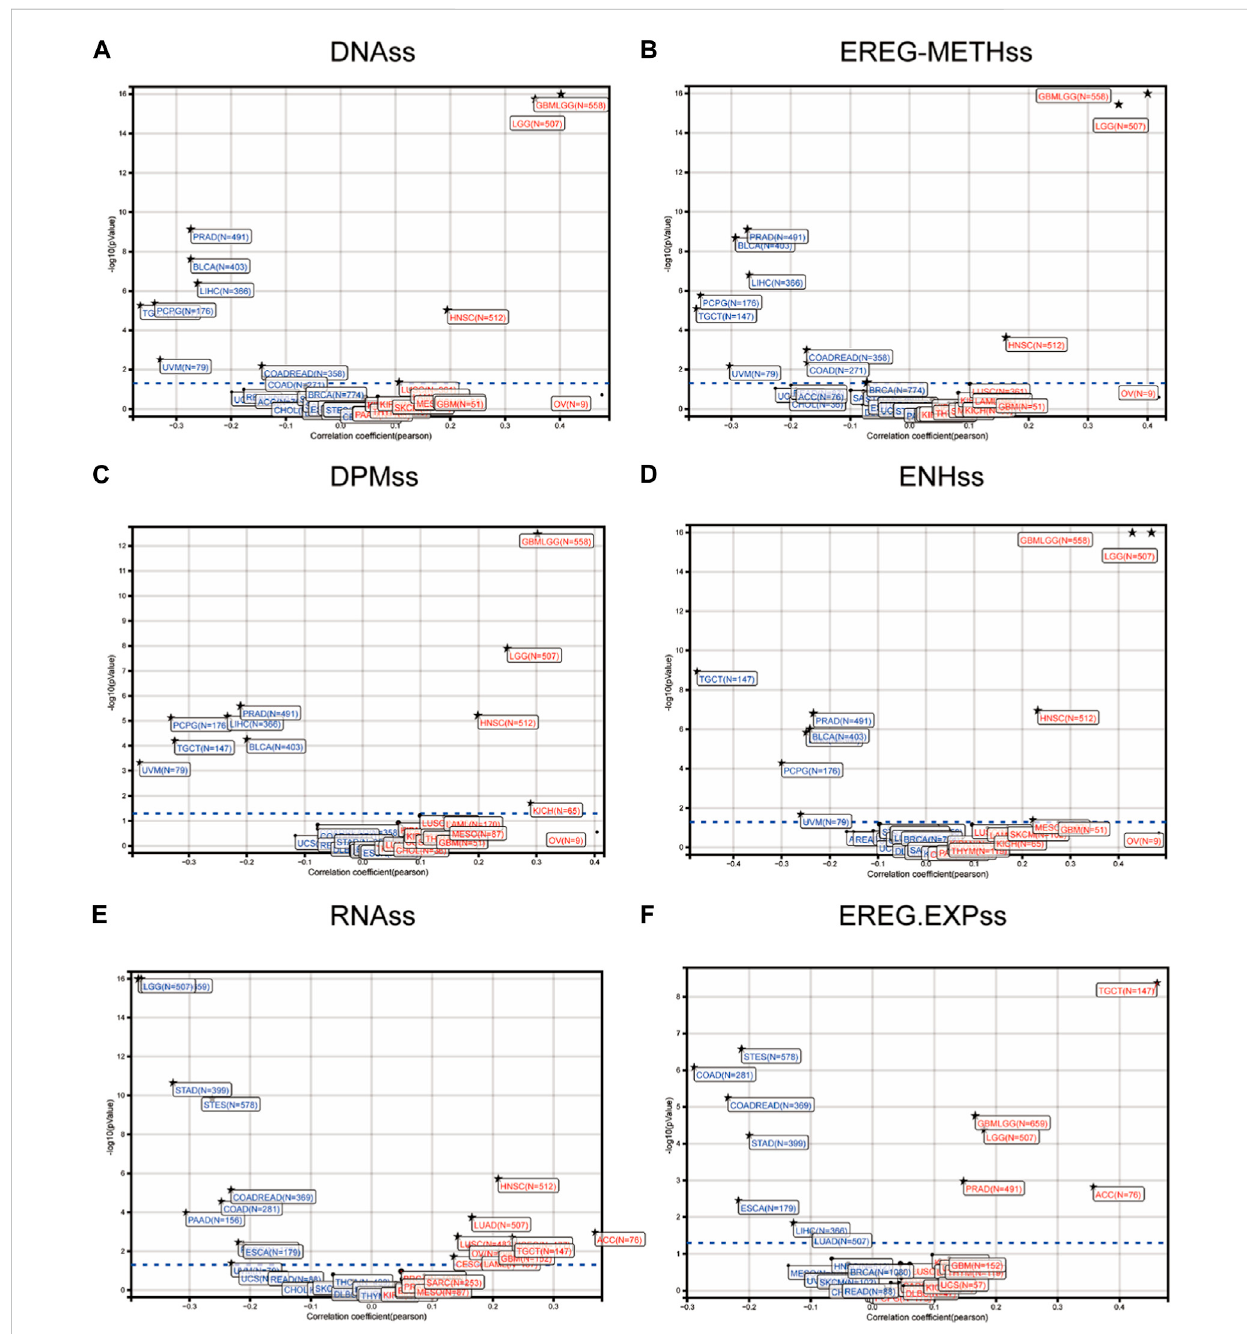
FIGURE 2 Correlation of stem cell index of FOXD3-AS1 in pan cancer tumor samples. (A) Scatter plots show that FOXD3-AS1 and the DNA methylation based Stemness Scores (DNAss), empirically regulated DNA methylation based (EREG-METHss) (B) , differentially methylated probes based (DMPss) (C) , Enhancer Elements/DNAmpli fi cation based (ENHss) (D) , RNA expression based score (RNAs) (E, F) and Epigenetically regulated RNA expression based (EREG.